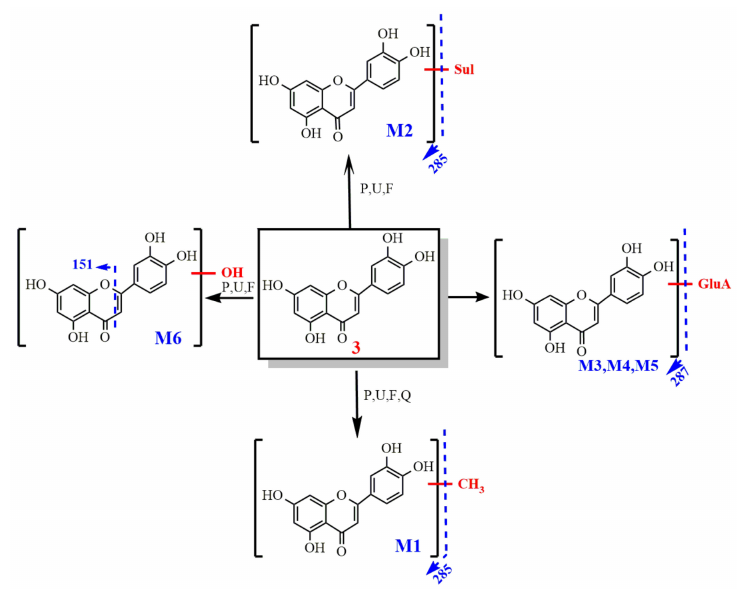
Figure 10. The metabolic pathway of luteolin.